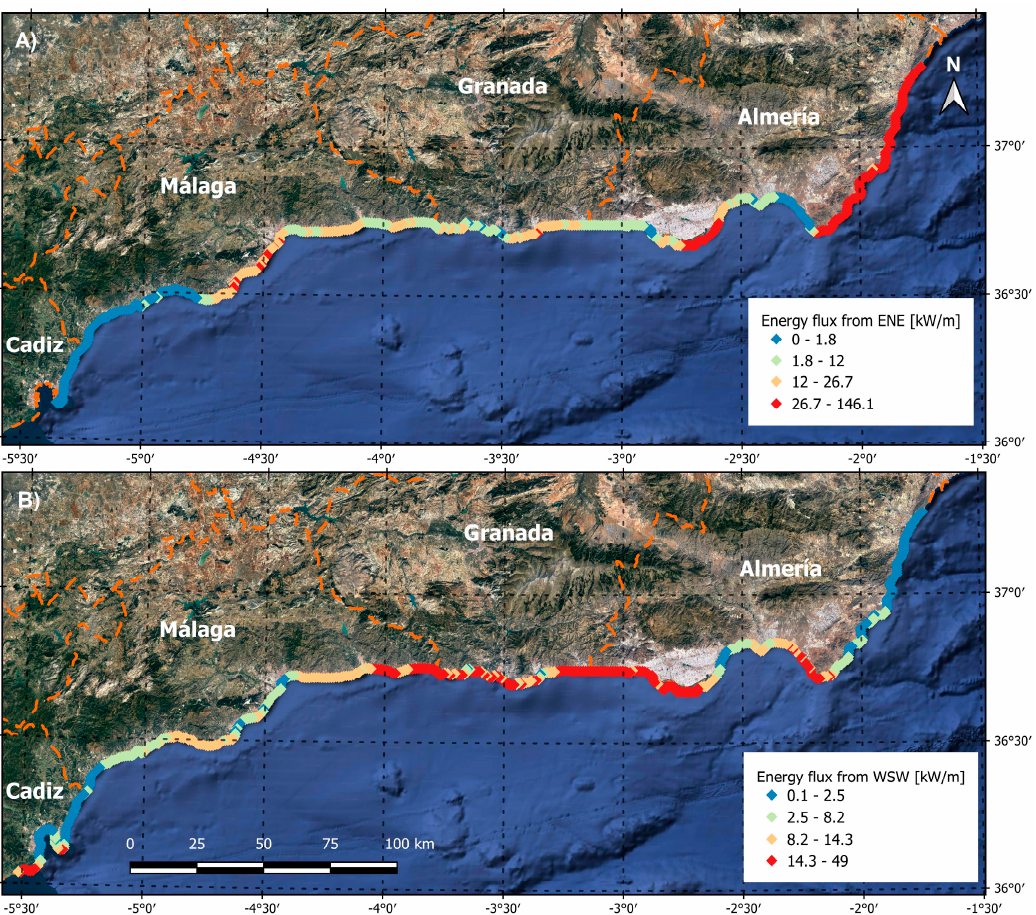
Figure 5. Energy flux distribution along the Andalusia coastline. Offshore boundary conditions: ( A ) mean wave direction = 67.5° ENE and wave height return period = 50 years (Figure 4A); ( B ) mean wave direction = 247.5° WSW and wave height return period = 50 years (Figure 4B).